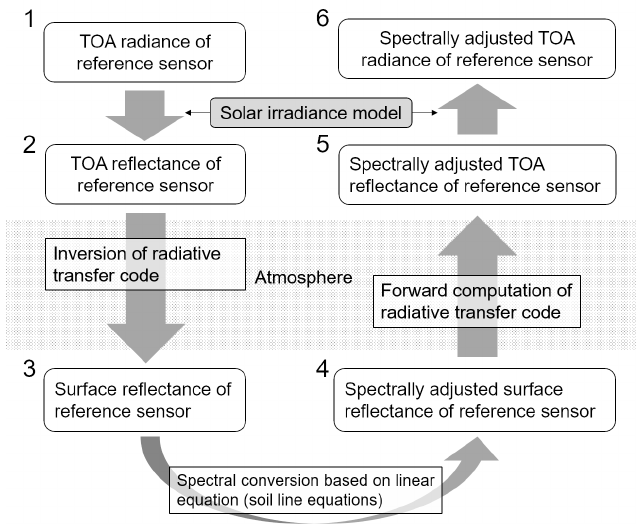
Figure 1. Illustration of model-based spectral band adjustment, including the conversion between radiance and